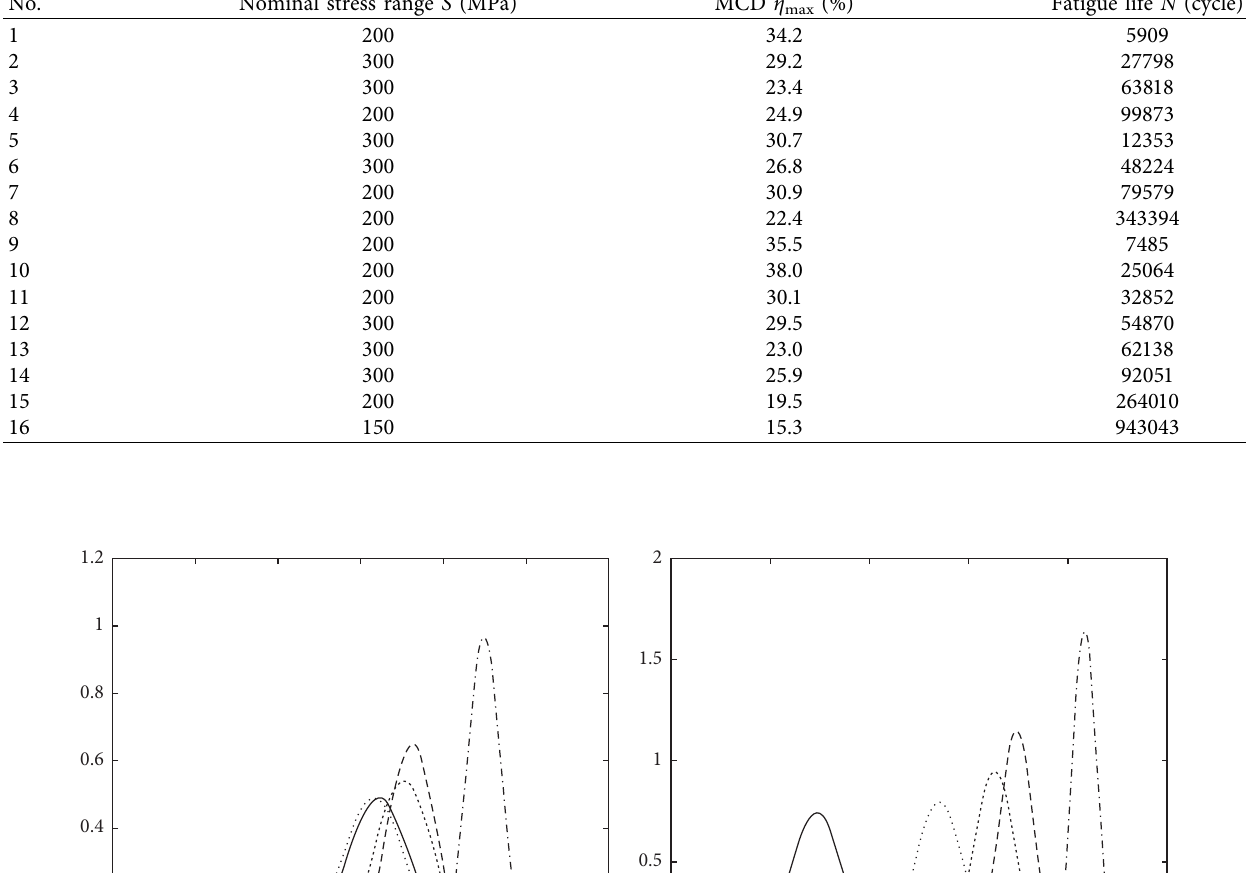
Table 4: Testing results (12mm-diameter bars) arbitrarily chosen from [13], representing observed data for Bayesian updating.